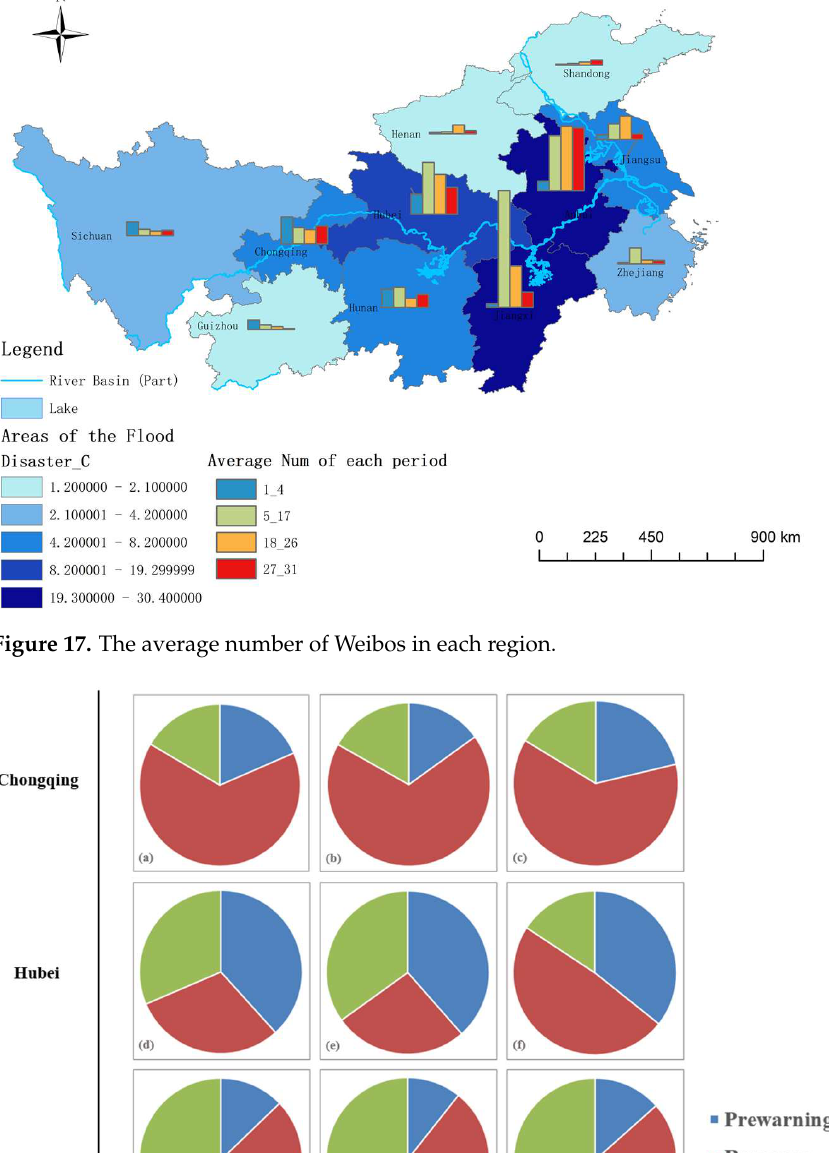
Figure 19. The proportion of different emotions in each status. Row1 represents the prewarning status, Row2 represents the response status, Row3 represents the recovery status, Colum1 repre- sents Anhui, Colum2 represents Hubei, and Colum3 represents Chongqing. According to Figure 18, each area had relatively similar characteristics at different phases, that is, the proportions of each status were close. However, the second phase of Hubei was quite different from the first phase. We assumed that this was because the second phase only lasted 5 days and the rainstorm in Hubei at this phase was rapid, so more attention was paid to the emergency response. In addition, three areas presented different modes. We assumed that more severe a flood, the larger the proportion of recov- ery. Figure 19 shows that the number of positive texts increased as the status evolved